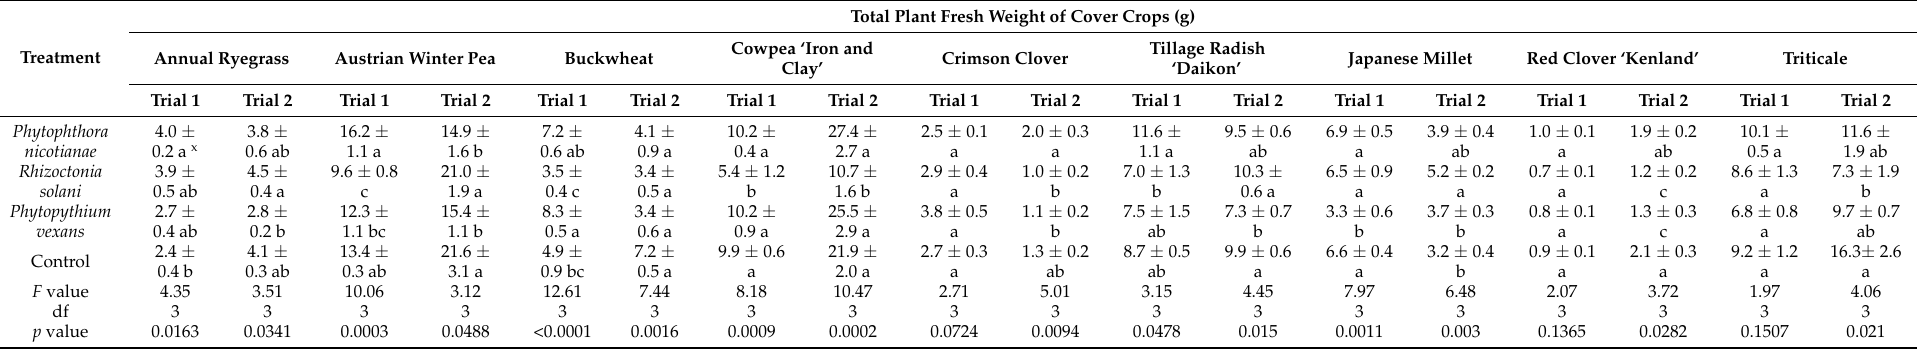
Table 3. Total plant fresh weight of different cover crops with the respective treatments of Phytophthora nicotianae , Phytopythium vexans , Rhizoctonia solani, and